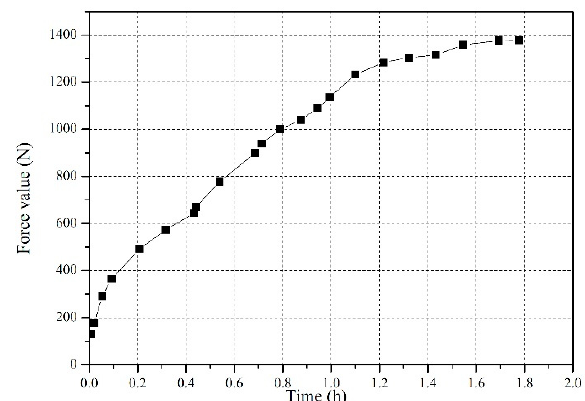
Figure 12. Test process of the specimen with a voids content of 5.2%.